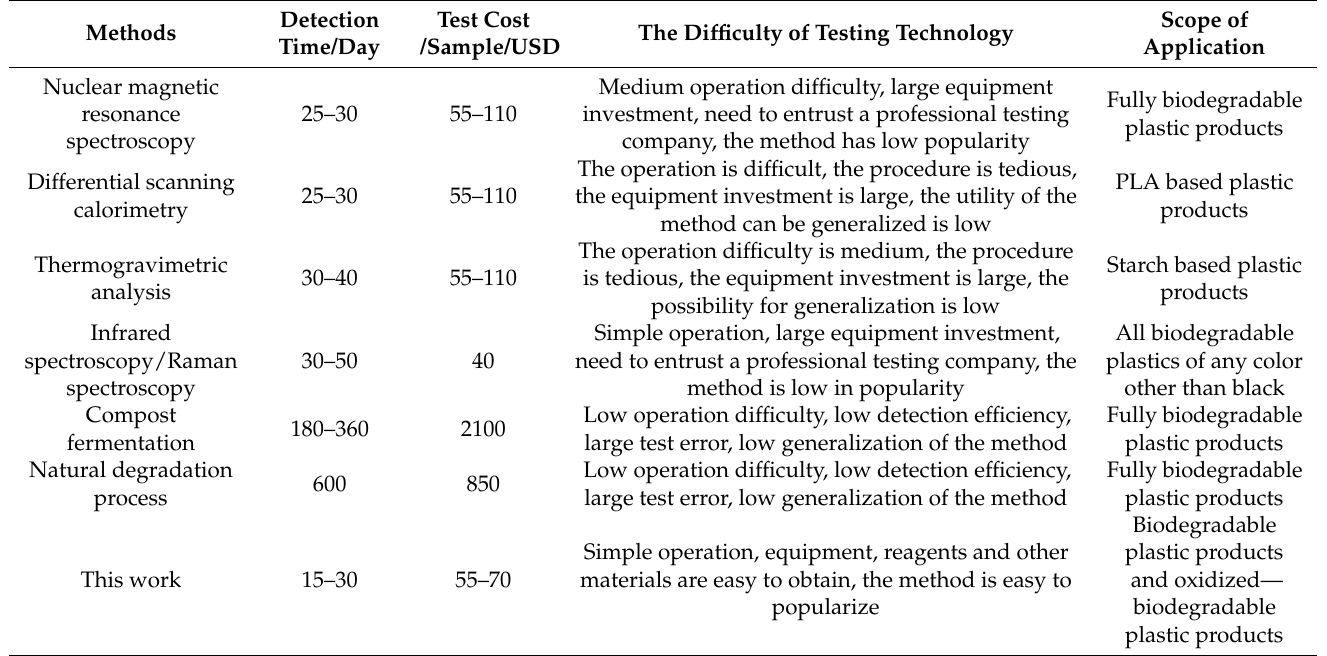
Table 5. Comparison of different detection